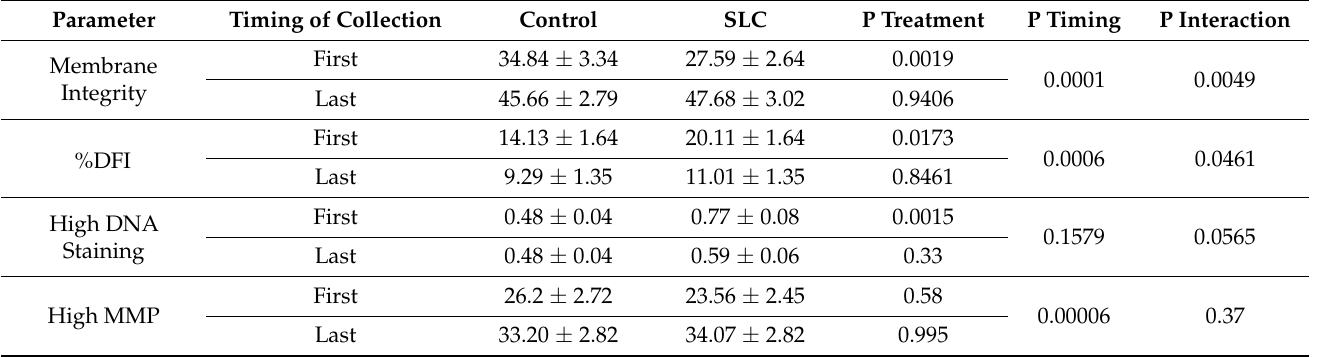
Table 2. Membrane integrity, %DFI, high DNA staining and high mitochondrial membrane potential in first and last young bull ejaculates (n = 19 bulls).